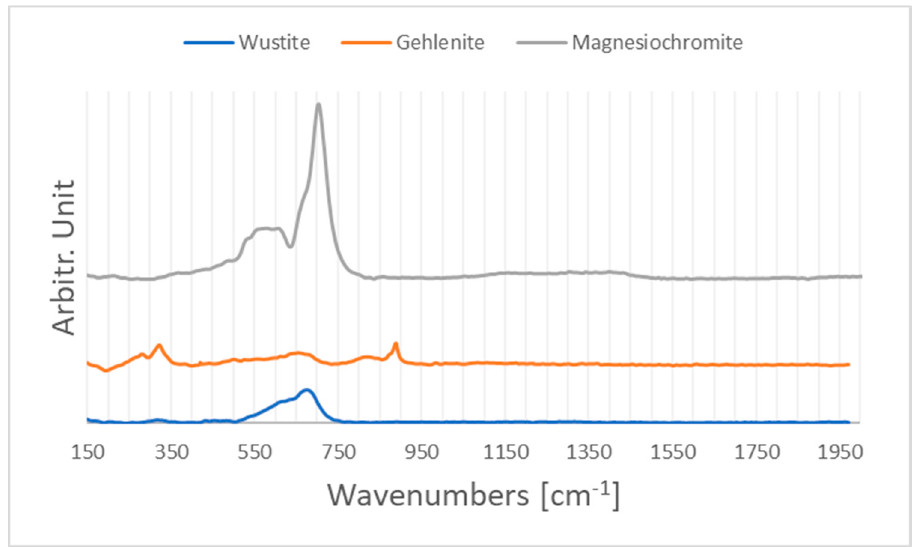
Figure 4. µ-Raman and spectra example of magnesiochromite, wüstite and gehlenite identified phases in samples B, C, D and E. Time measurement 50 s.